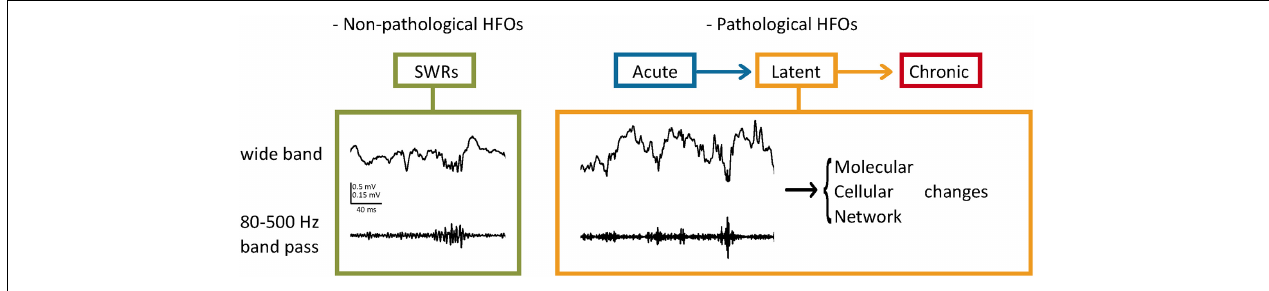
FIGURE 1 | Pathological HFOs and their possible role during the latent phase of TLE. (Left) SWRs as an example of non-pathological HFOs. In the hippocampus, HFOs (80–200 Hz) called ripples are associated with high amplitude activities (Sharp Wave Ripples, SWRs) and contribute to neuronal plasticity and memory consolidation. (Right) Pathological HFOs during the latent phase of TLE. Higher frequencies of oscillations (200–500 Hz) are observed between the acute and chronic stages without behavioral expression of seizures. Neuronal activities leading to the pathological HFOs are suggested to result in long-term molecular and cellular changes. Circuit rewiring caused by these changes might make the more brain areas prone to SRSs, leading to further progression of